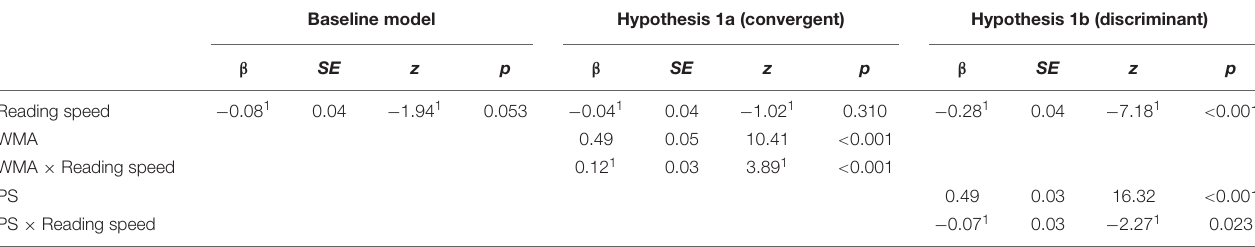
TABLE 1 | Interaction effects of component skills – word meaning activation (WMA) and perceptual speed (PS) – and reading speed on reading ability. Baseline model